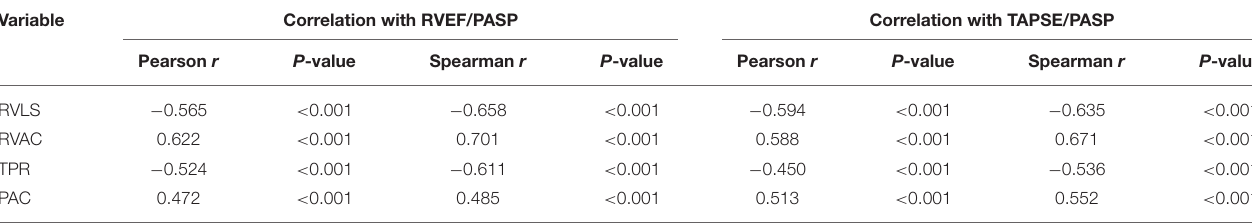
TABLE 3 | Correlations of RVEF/PASP and TAPSE/PASP ratios with RV contractile function and RV-PA coupling. Variable